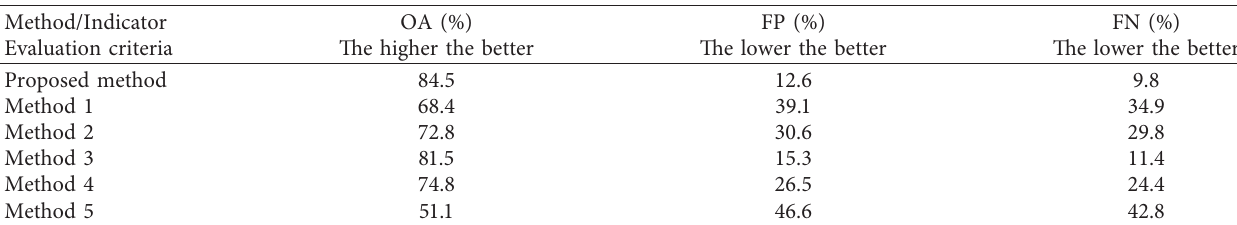
Table 5: Quantitative evaluation of CD accuracy in dataset 2.